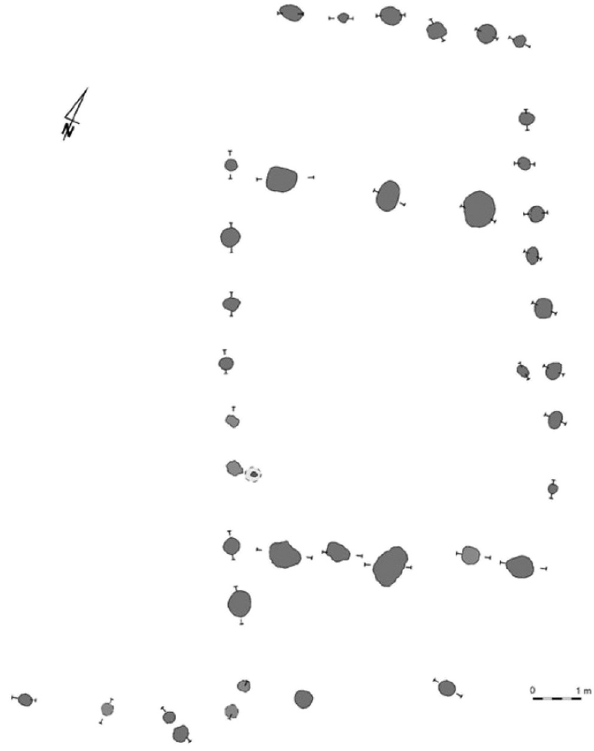
Figure 5: MC house no. 2560 in Targowisko site 10 – 11 ( acc. to Grabowska & Zastawny, 2014 ) .